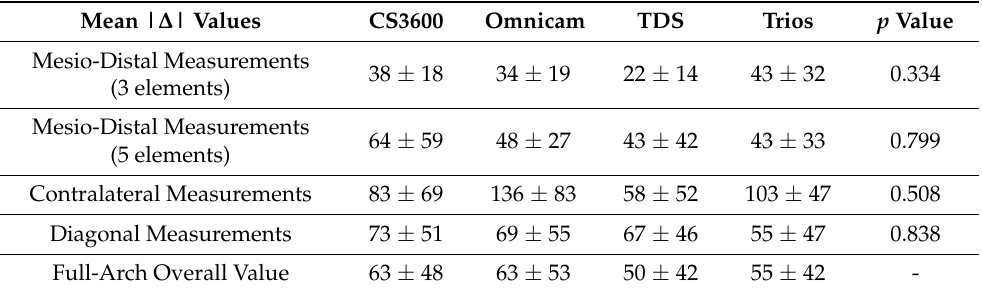
Table 2. Mean | ∆ | values ( µ